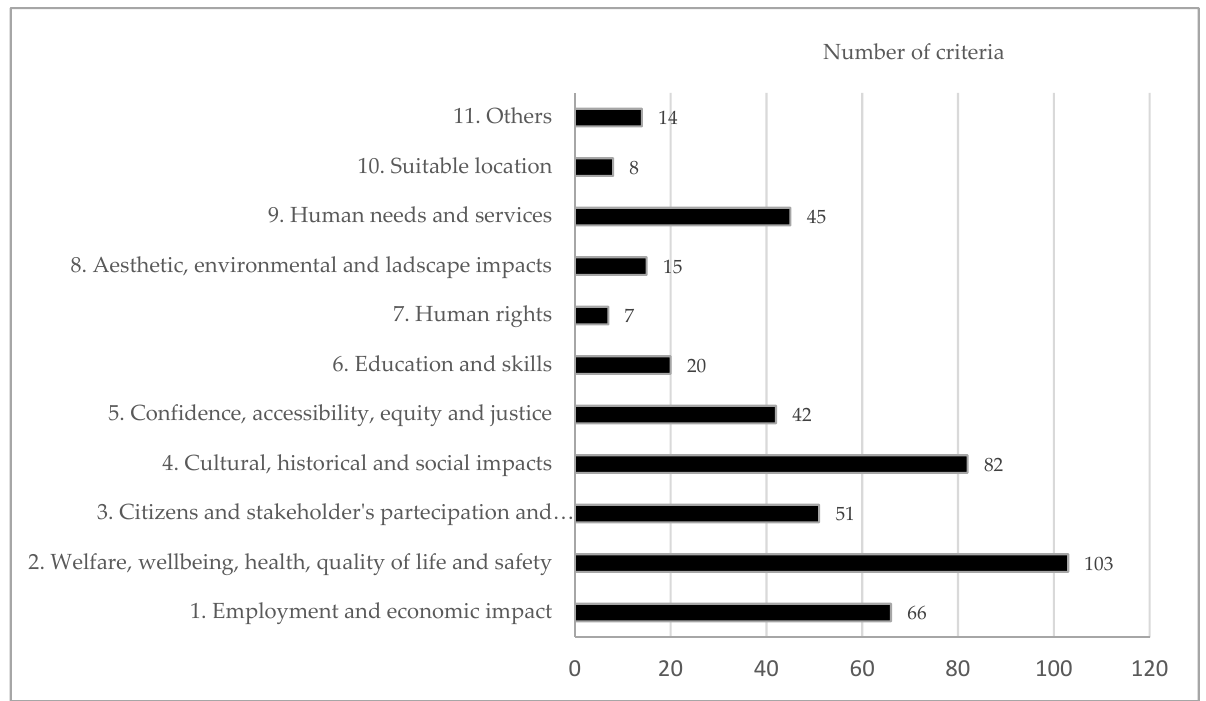
Figure 4. Categories of social criteria used in evaluating applications of infrastructure projects.